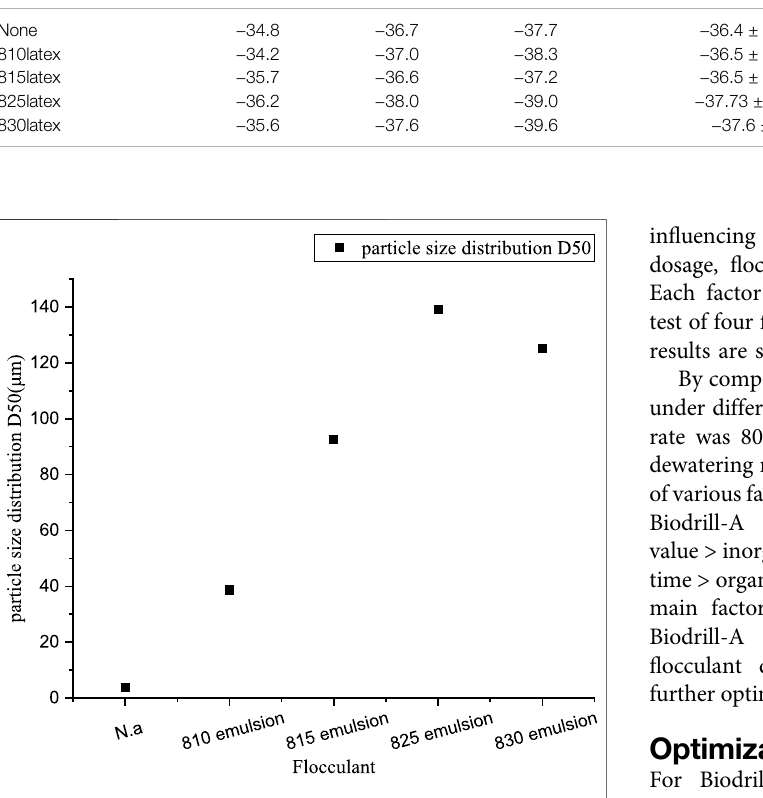
FIGURE 4 | In fl uence of the organic fl occulant on the particle size distribution in Biodrill-A drilling fl uid (D50).